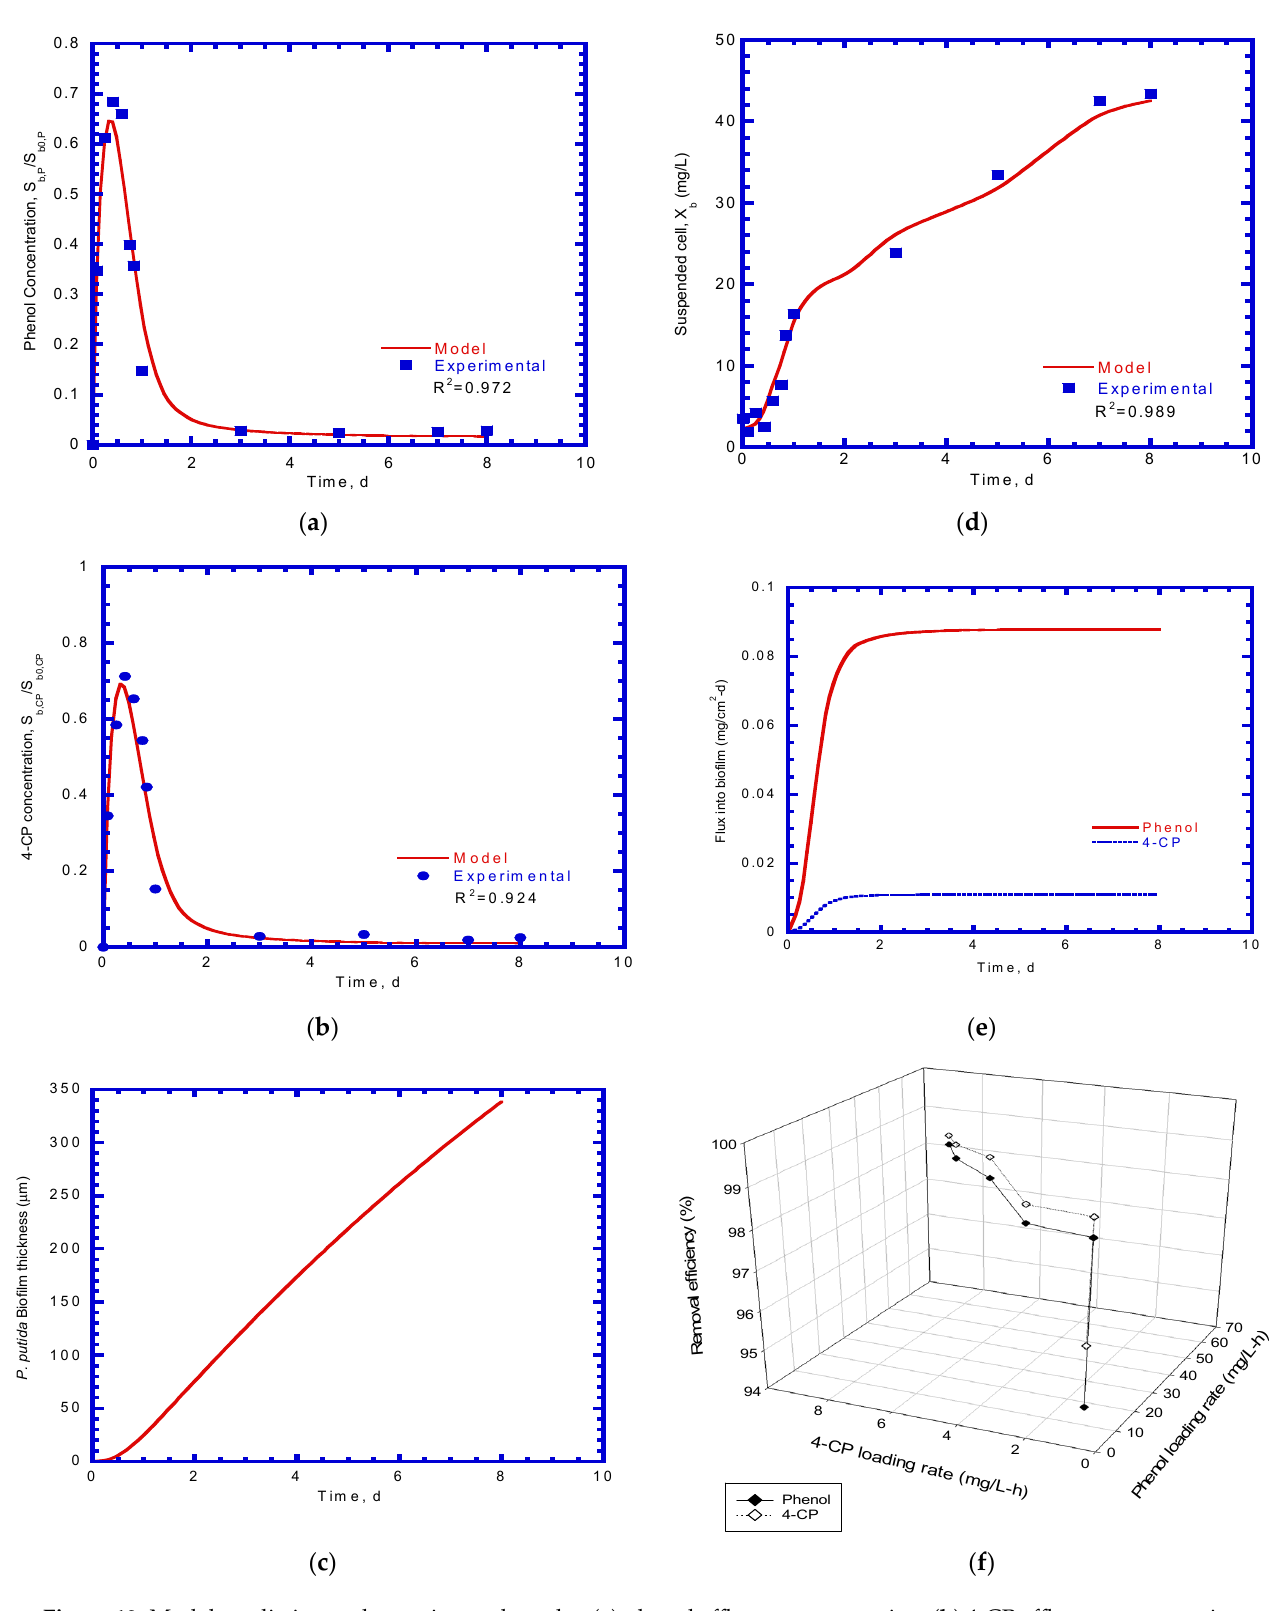
Figure 10. Model prediction and experimental results: ( a ) phenol effluent concentration; ( b ) 4-CP effluent concentration; ( c ) P. putida biofilm growth; ( d ) P. putida suspended cells growth; ( e ) phenol and 4-CP fluxes into biofilm; and ( f ) effect of substrate load on removal efficiency.